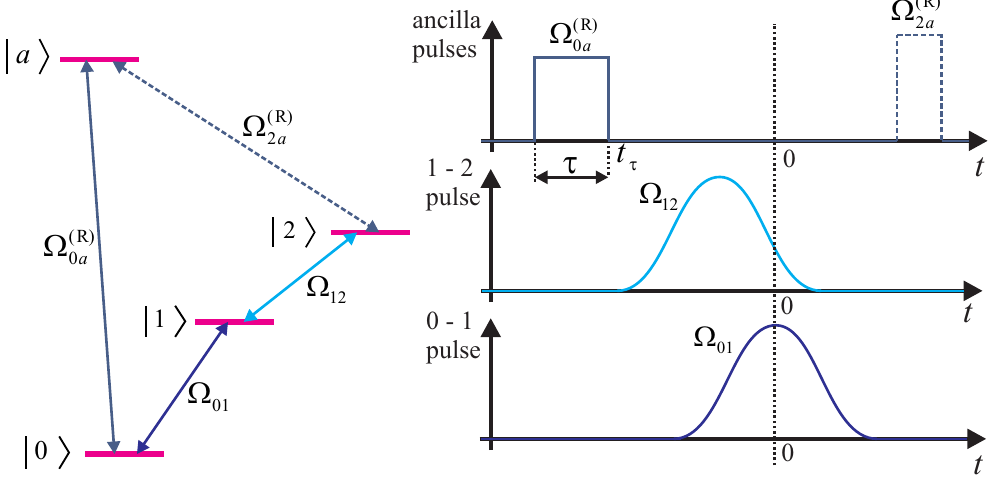
Figure 6. Schematic of the three-level system augmented by a fourth ancillary state | a (cid:105) . The nonadiabatic pulse couples the states | 0 (cid:105) and | a (cid:105) and the two STIRAP pulses drive the transitions 0–1 and